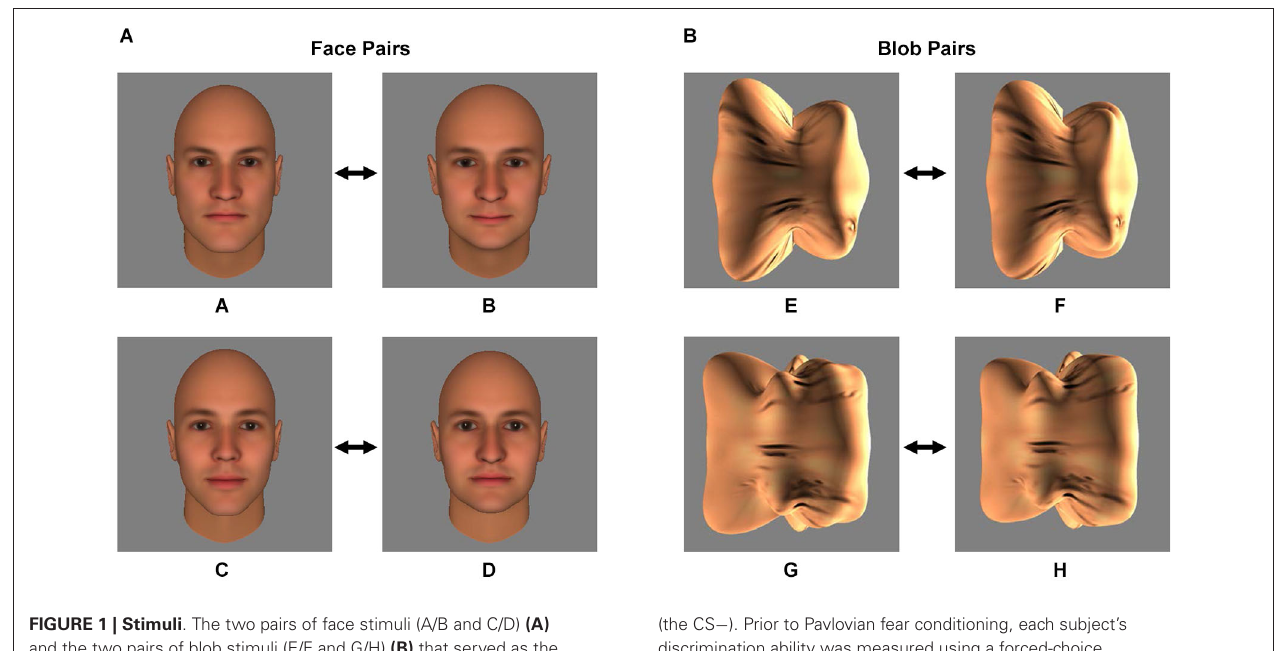
FIGURE 1 | Stimuli . The two pairs of face stimuli (A/B and C/D) (A) and the two pairs of blob stimuli (E/F and G/H) (B) that served as the conditioned stimuli (CS) during the Pavlovian fear conditioning procedure are shown. During the procedure, one of the two stimuli of the pair was followed by an electrical shock (the CS+) and one was not